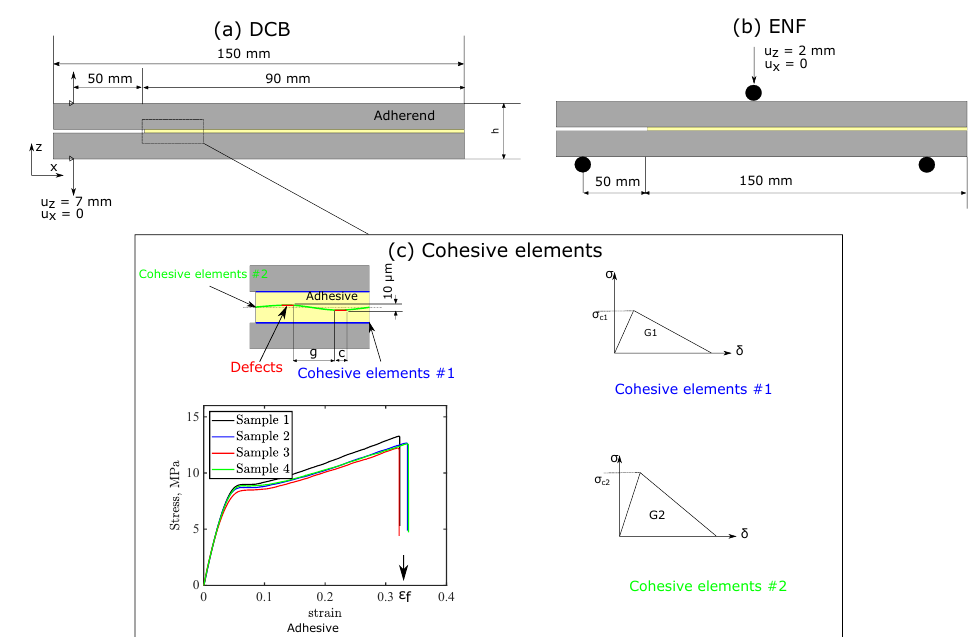
Figure 3. Two-dimensional models: ( a ) double cantilever beam (DCB), ( b ) end notch flexural (ENF) tests for bonded joints with thermoplastic adhesive tapes incorporating tailored defects, and ( c ) the cohesive interfaces and tailored defect details with tape’s stress–strain